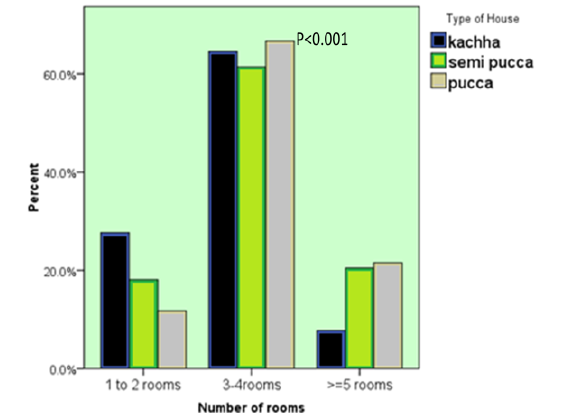
Fig.3. Number of rooms according to type of house.